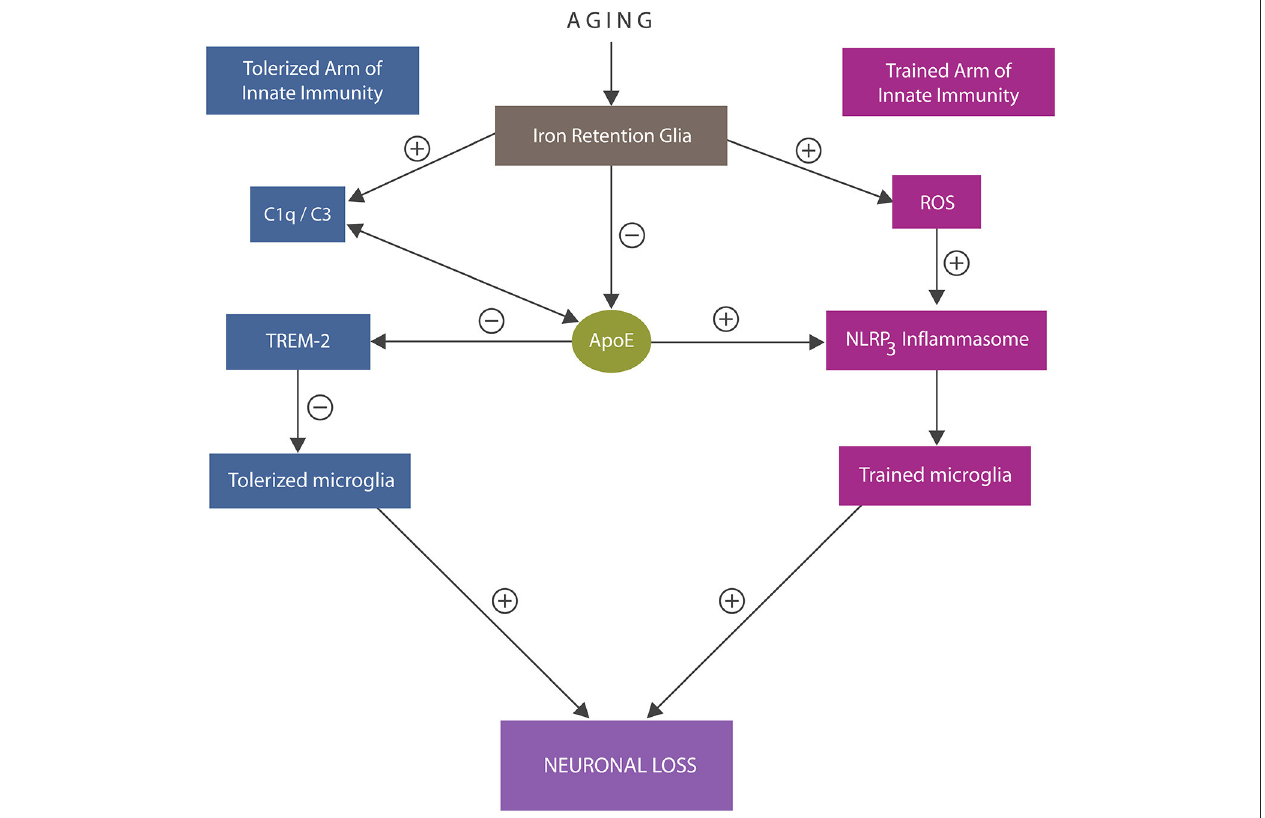
FIGURE 3 | An overview of the trained and tolerized arm of innate immunity. Trained arm: excess iron and ROS trigger activation of NLRP3 inflammasomes with excessively trained microglia and neuroinflammation that may override tolerization. In addition, iron lowers ApoE expression and alters C1q and C3, further impairing tolerization via ApoE -TREM-2 axis. Both excessive immune training or insufficiently tolerized microglia may trigger neuronal loss. ApoE4 isoform binding C1q triggers inappropriate elimination of healthy synapses by astrocytes, likely by promoting the A1 cells.